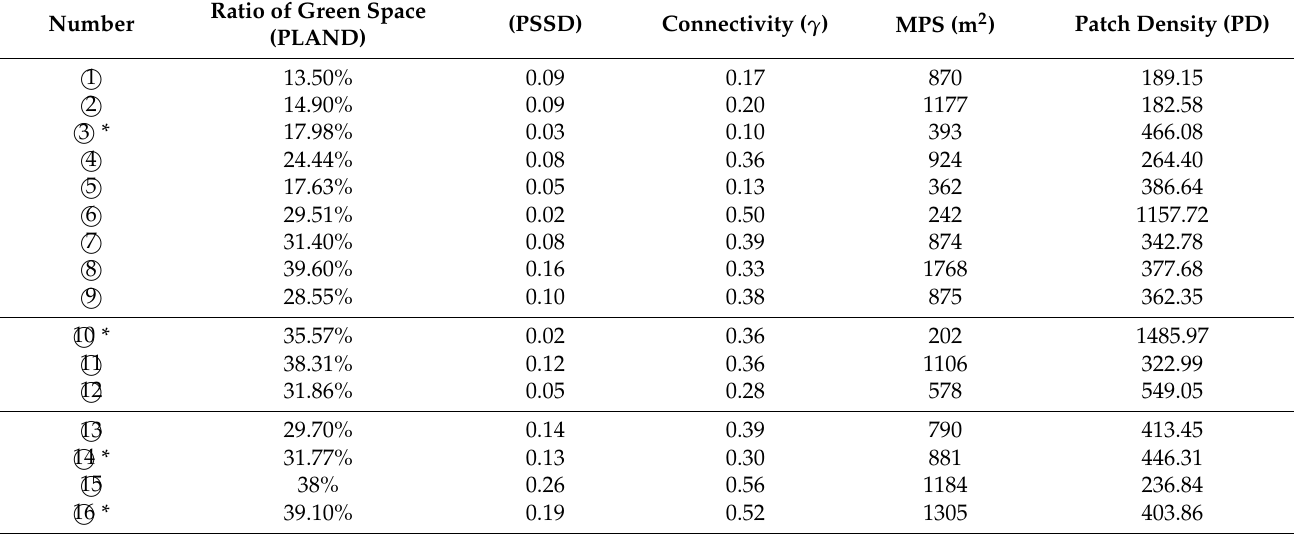
Table 1. Distribution characteristics for 16 Tianjin